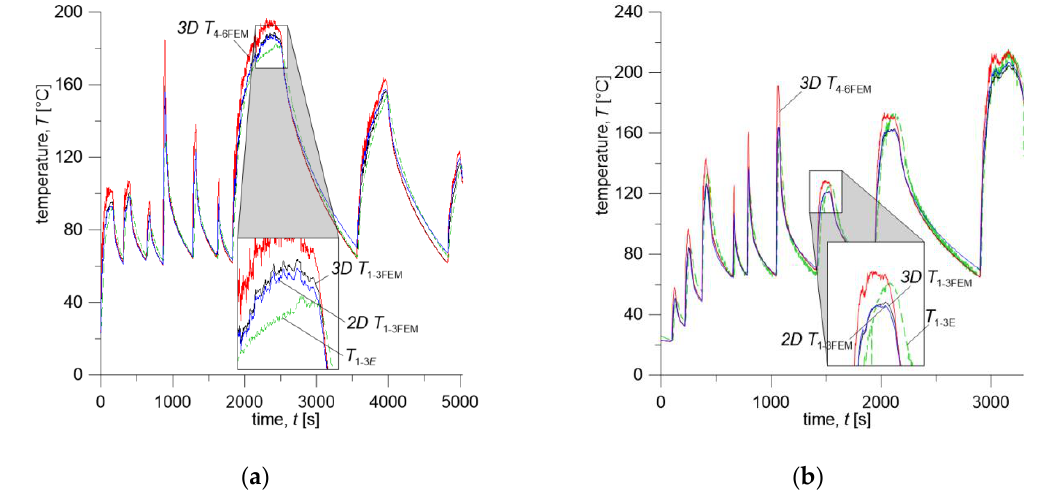
Figure 8. Mean temperature changes: ( a ) Material A; ( b ) Material B; average values from three thermocouples (dashed lines) T 1 − 3 E , three points from 3D and 2D numerical calculations under the surface of the wheel T 1 − 3 FEM and three points on the surface of the wheel 3D T 4 − 6 FEM .